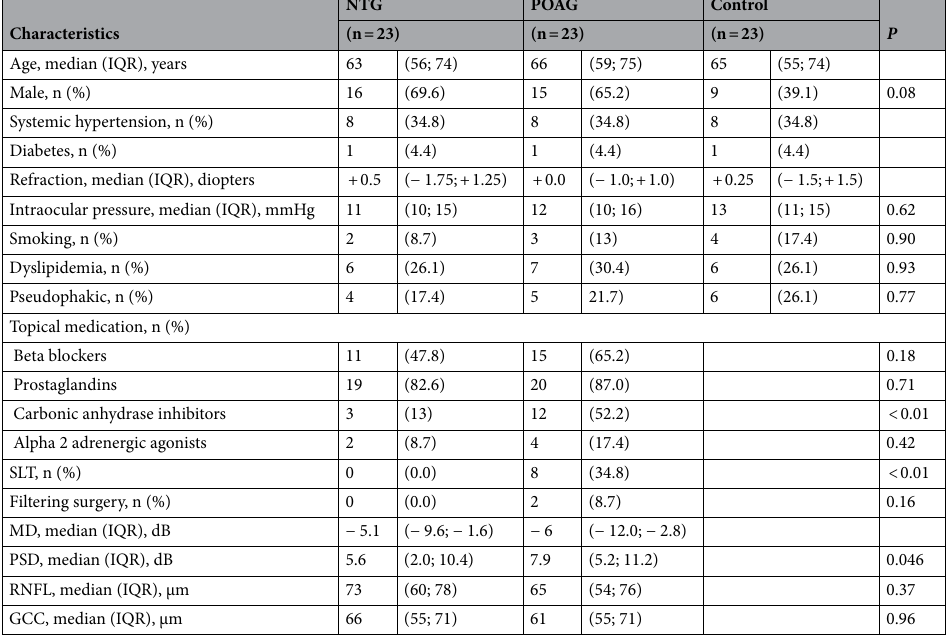
Table 1. Comparison of baseline characteristics for Normal tension glaucoma (NTG), primary open-angle glaucoma (POAG) and control groups. GCC Ganglion cell complex, IQR interquartile range (i.e., 25–75th